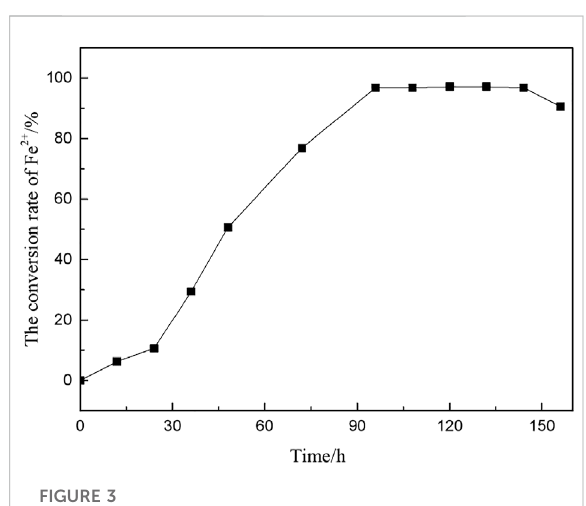
FIGURE 3 Variation trend of Fe 2+ conversion rate over